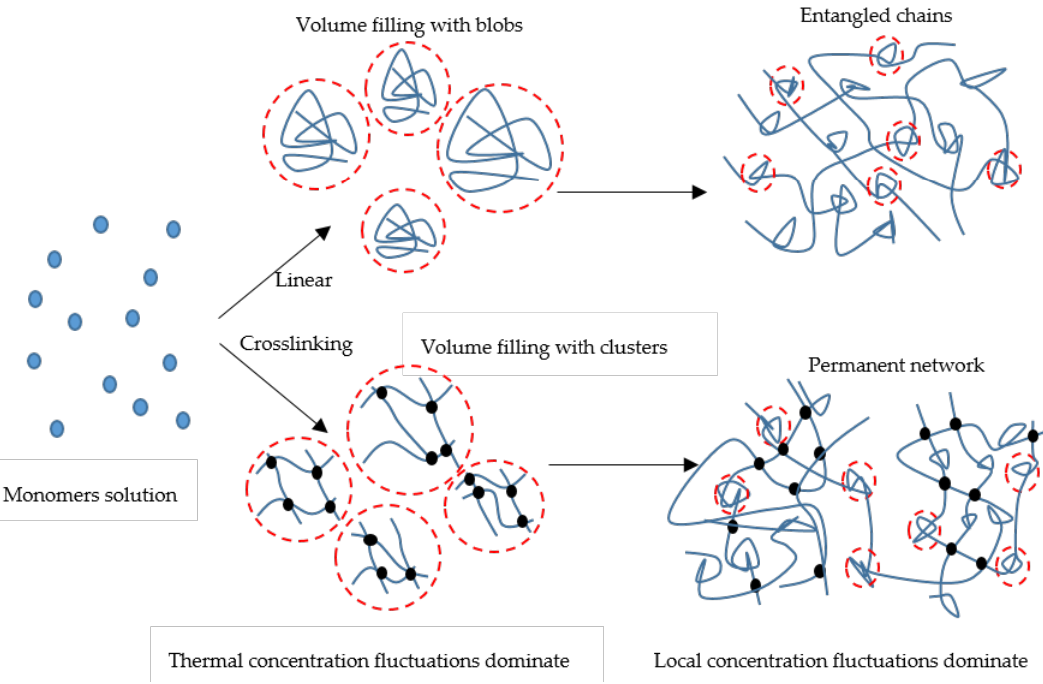
Figure 3. Depiction of different time-stages in linear polymerization and gel formation processes and their impact on static light scattering (SLS) intensity (scheme adapted from [24,39,40] with the publisher’s permission).